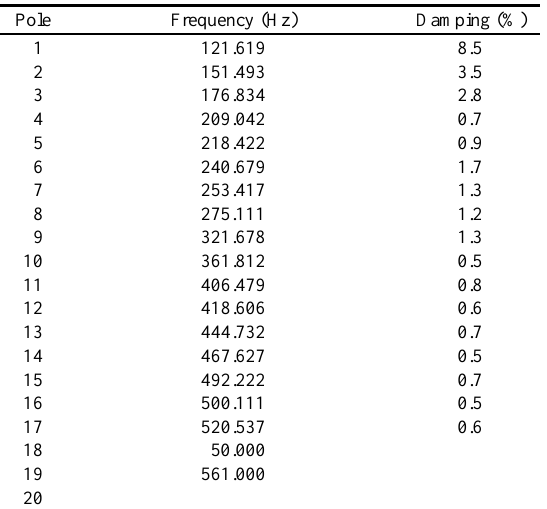
Table 1 Modal parameter